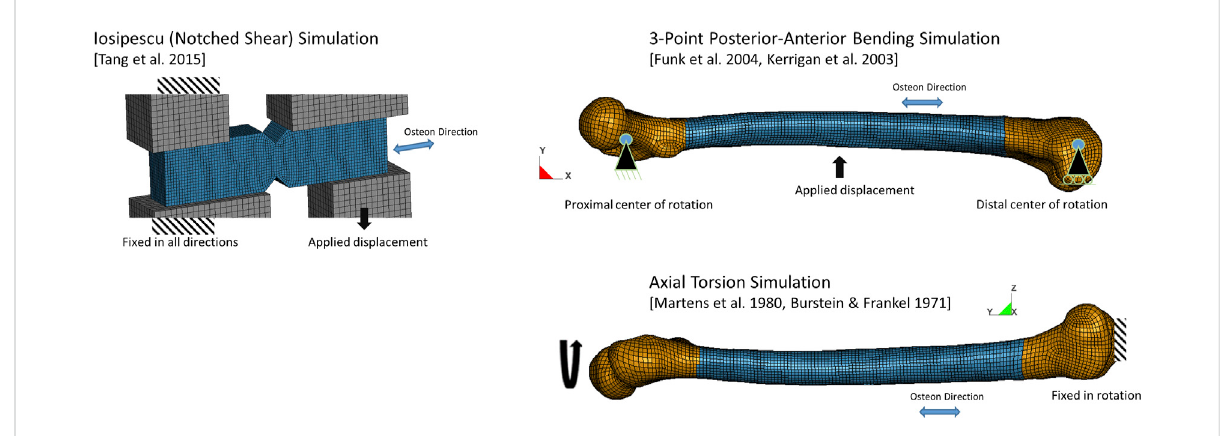
FIGURE 3 Finite element models of load cases and boundary